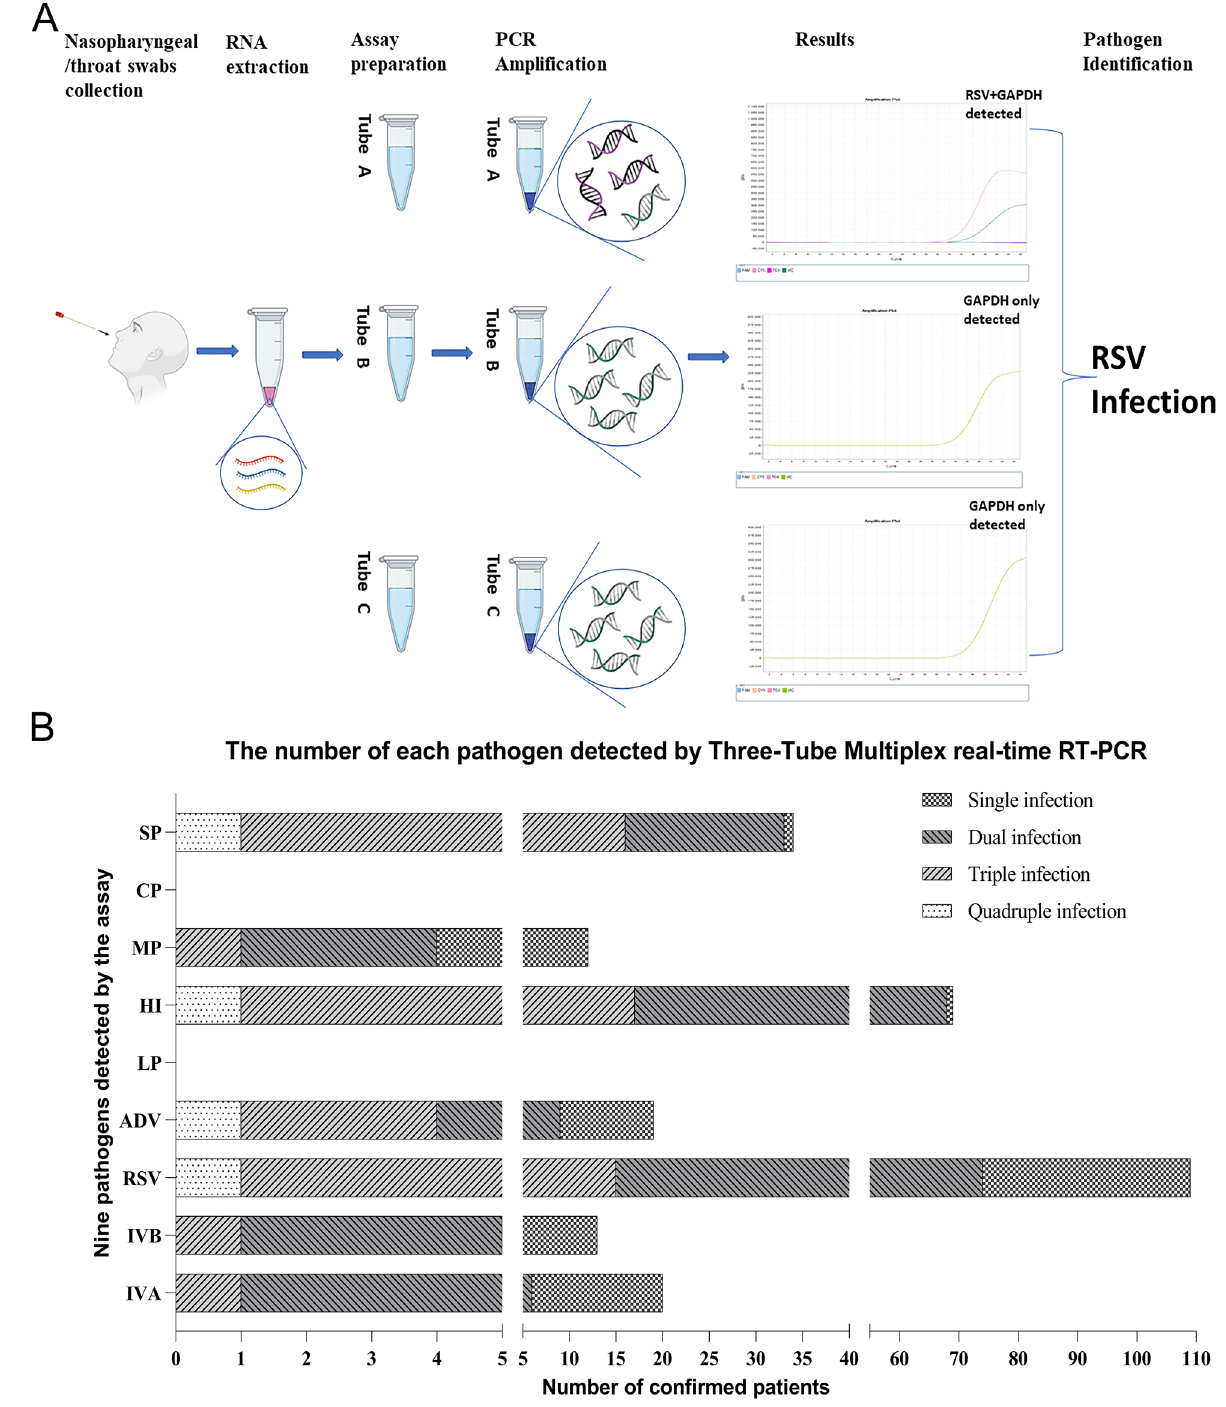
Figure 4. Diagnostic performance evaluation of the multiplex real-time RT-PCR. A, schematic representation of flow chart of the multiplex real-time PCR assay for detection of clinical specimens. After the patient’s nasopharyngeal/throat swab is taken, the nucleic acid extracted from the sample is amplified simultaneously in three tubes by the multiplex PCR assay. If the fluorescence channel of RSV in tube A shows an amplification curve and GAPDH is detected in all three tubes, a valid sample collection can be diagnostic for RSV infection in the sample. B, the number of each pathogen detected by three-tube nine-plex real-time PCR. The total number of pathogens detected in each type of infection were as follows: Single, 7; Dual, 7; Triple, 7; Quadruple, 4. LP: Legionella pneumophila , HI: Haemophilus influenzae , MP: Mycoplasma pneumoniae , CP: Chlamydia pneumoniae , SP: Streptococcus pneumoniae